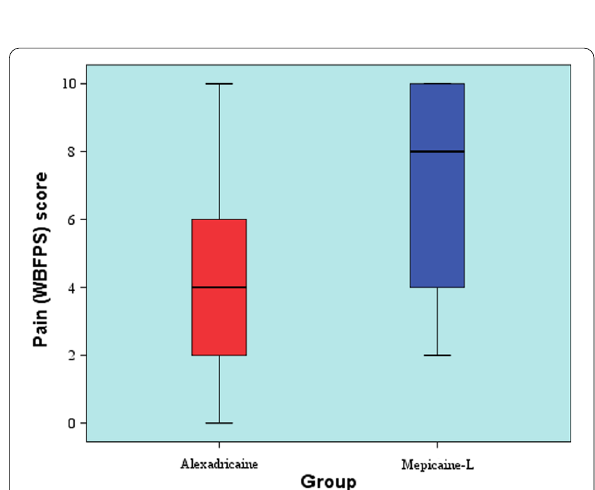
Fig. 4 Box plot representing median and range values for pain scores in the two groups according to Wong–Baker facial pain rating scale